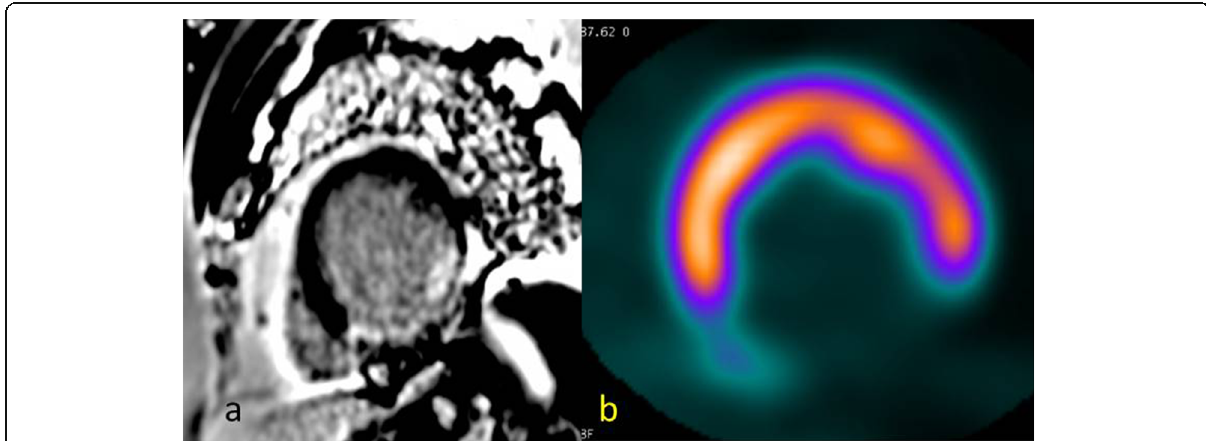
Fig. 3 A 57-year-old male with triple vessel disease. a Free-breathing delayed contrast-enhanced MRI in short-axis view reveals late gadolinium